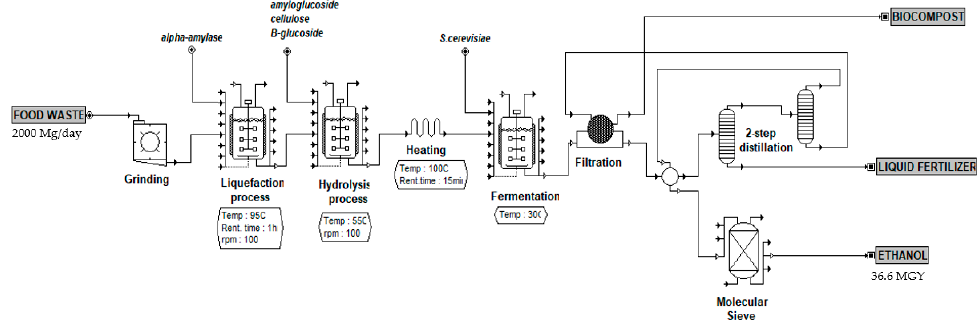
Figure 2. Process flow diagram of the scenario B FW fermentation process with hydrolysis enzymes and a 2-step distillation system.